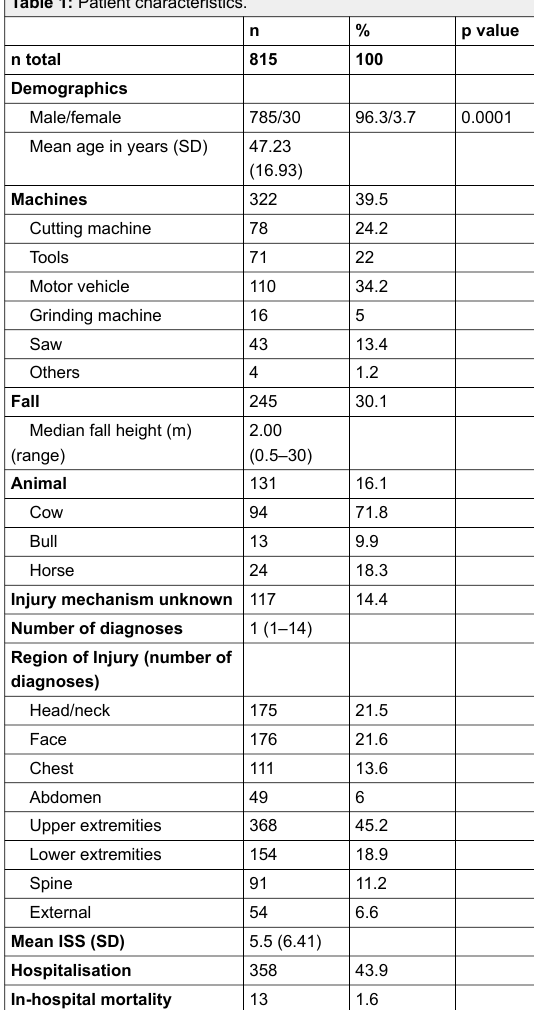
Table 1: Patient